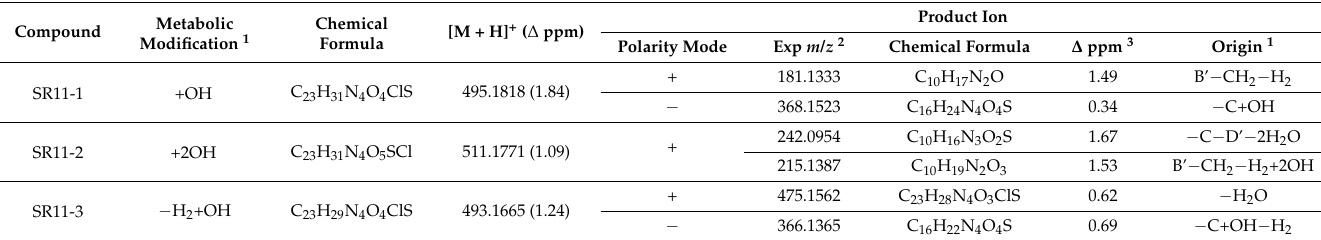
Table 3. Characterization of metabolites detected in HLM incubation samples with SR9011 by LC–HRMS